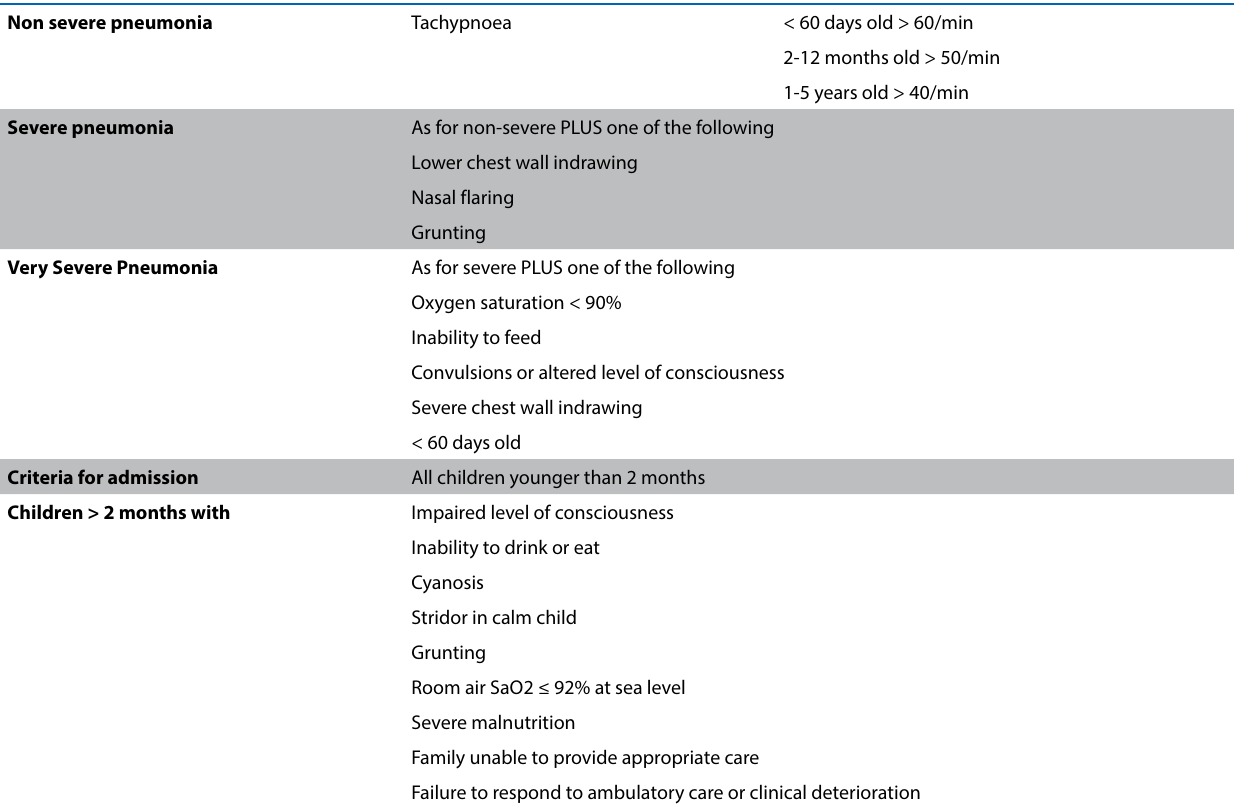
Table 1: Classification of pneumonia in children Non severe pneumonia